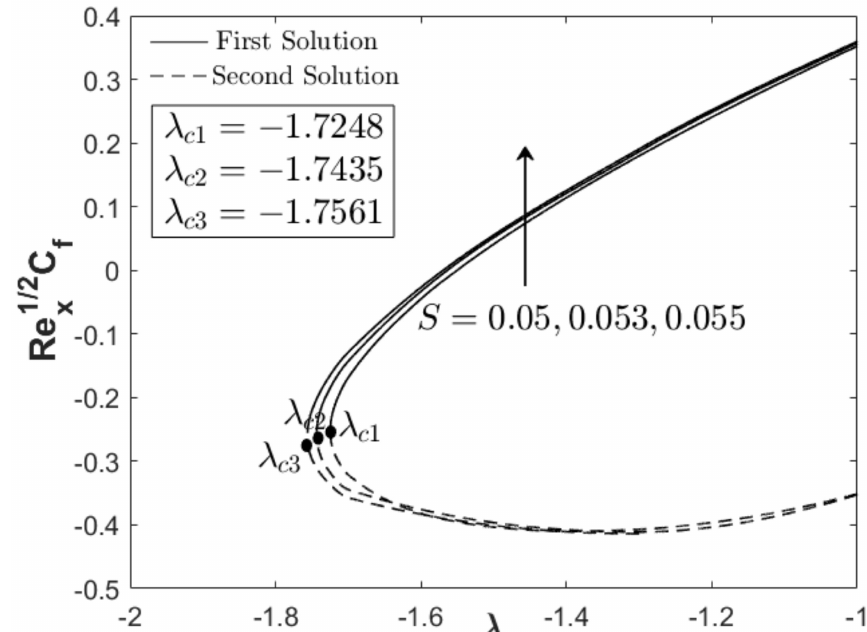
Figure 4. Re 1/2 x C f towards λ when m = 0.3, φ hnf = 0.02, and variety S .